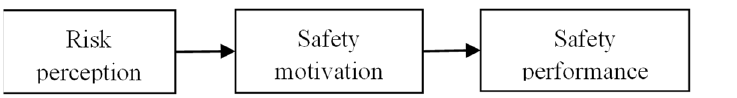
Figure 2. Hypothesized model of mediating effect of SMO between RPC and SP. Hypothesis 7. SMO performs a significant and positive mediating effect between OC and SP.